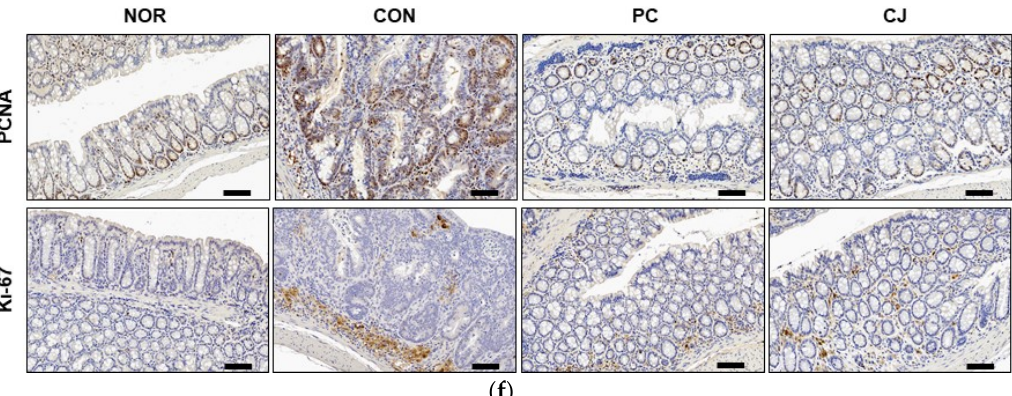
Figure 6. Effects of CJ on the expression of apoptosis and proliferation-related proteins in mice with DSS-induced colitis. mRNA levels of ( a ) p53, ( b ) Bax, ( c ) Bcl-2, and ( d ) Bcl-X L in the different groups of mice were measured by qRT-PCR. ( e ) Protein levels of p53, Bax, Bcl-2, and Bcl-X L were determined by western blotting. ( f ) Representative images of the colonic tissue immunohistochemically stained with PCNA and Ki67. Magnification, 200×; Scale bar, 60 μ m. Values are means ± standard deviation ( n = 8); NOR, normal group; CON, control group; PC, positive control group; CJ, cheonggukjang treated group. #, p < 0.05 versus normal group; ***, p < 0.001; **, p < 0.005; *, p < 0.05 versus control group.